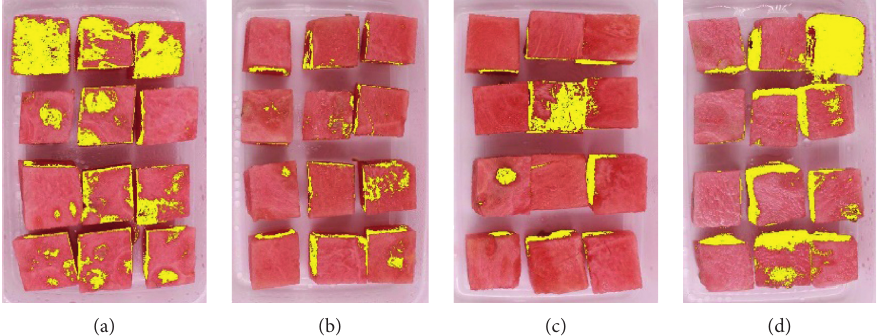
Figure 2: Effect of light exposures on water-soaking symptom of the fresh-cut watermelon. The water-soaking symptom is marked in yellow. Data are mean ± standard deviation ( n ≥ 3). Means with different letter represent a significant difference ( P < 0 . 05): (a) control, (b) red, (c) green, and (d) blue.